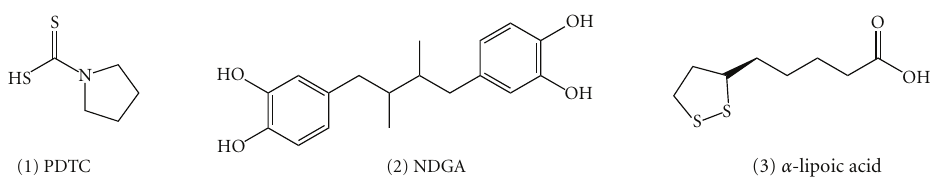
Figure 4: Pharmacological agents with inhibitory e ff ect on the induction of apoptosis in human fetal membrane cells. Abbreviations used: NDGA, nordihydroguaiaretic acid; PDTC, pyrrolidine